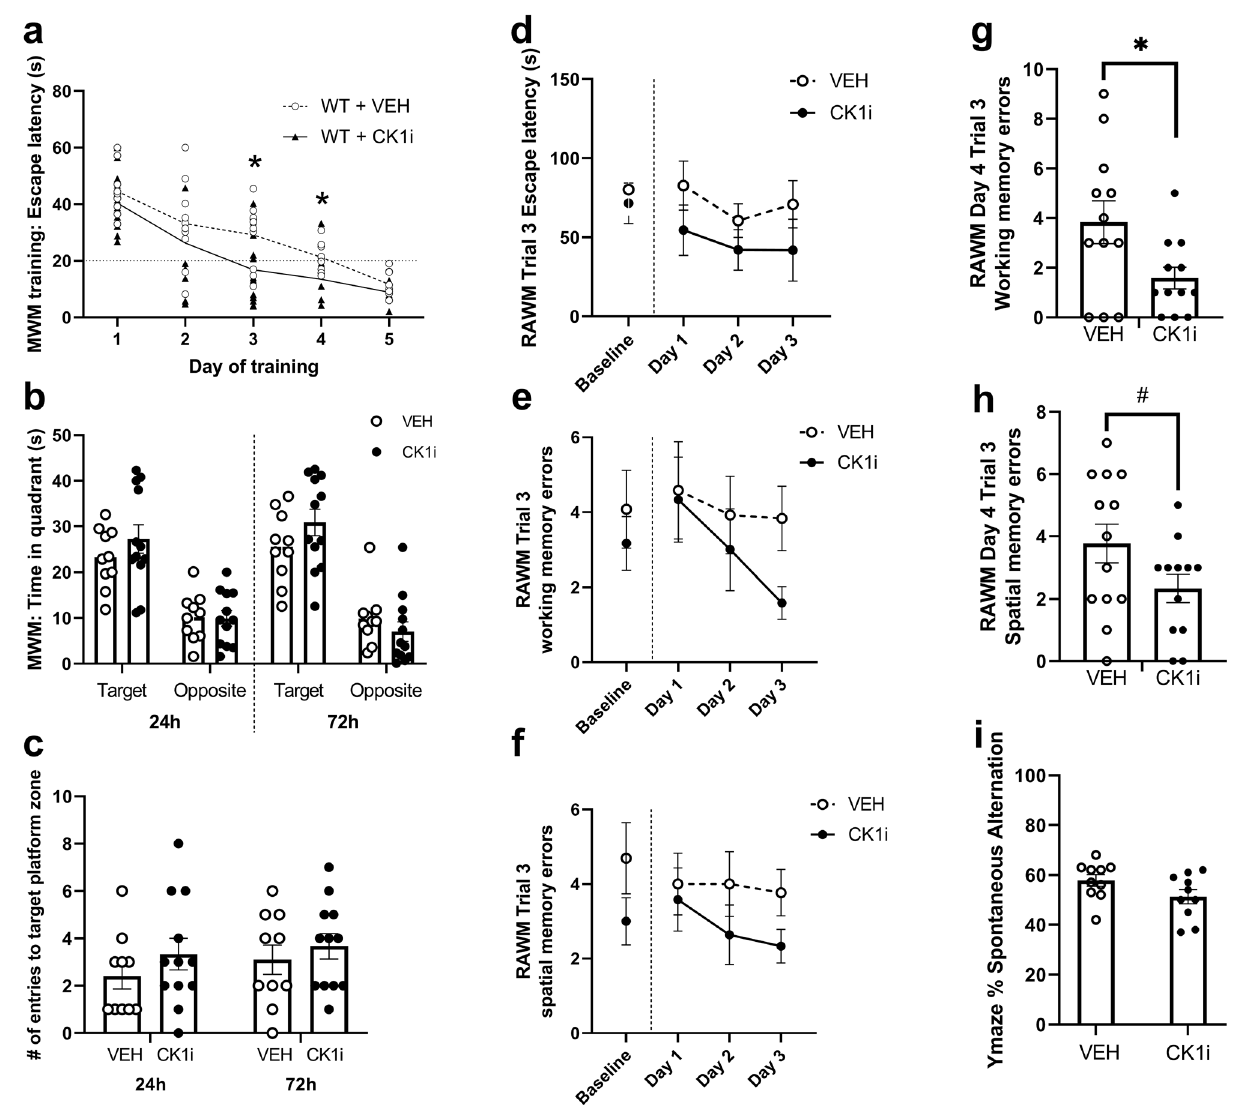
Figure 4. CK1 inhibition with PF-670462 improves spatial learning behavior but not recall in the Morris water maze, and working memory performance in the radial arm water maze but not Y maze. ( a ) Escape latency over 5 days of training in the Morris water maze (MWM). Dotted line indicates goal latency of 20 s. ( b ) Time spent in target and opposite quadrants of the MWM pool during probe trials conducted 24 and 72 h after the completion of training. ( c ) Number of entries during the probe trials to the area of the pool that previously contained the escape platform. ( d ) Escape latency from the 6-arm radial arm water maze (RAWM) over 4 days of testing. ( e ) Working memory type errors over time in the RAWM. ( f ) Spatial memory type errors over time in the RAWM. ( g ) Working memory type errors in RAWM in the final trial on the last day of testing. ( h ) Spatial memory type errors in RAWM in the final trial on the last day of testing. ( i ) Percent spontaneous alternation in the Y-maze. Each dot represents a mouse. Data are represented as mean ± SEM. *p < 0.05, # p = ANOVA was significant for training day (F(2.414, 45.88) = 31.67, p < 0.0001) and treatment (F(1, 20) = 9.365, p = 0.0062), but not the interaction (F(4, 76) = 0.7439, p = 0.5650). CK1i-treated mice found the escape platform more quickly on the third (t(20) = 2.4363, p = 0.0243) and fourth (t(19) = 2.5911, p = 0.0179) days of training. By day 5 of training, untreated mice had similar escape latency to CK1i-treated mice (t(19) = 1.8451, p = 0.0807) (Fig. 4a). We found no difference in the amount of time spent in the target or opposite quadrant, or in the num- ber of entries to the target platform area in either the 24 or 72 h probe tests. (Fig. 4b,c). Although the results from FC and MWM in our first set of behavioral tests both suggested mild improve- ment in cognitive performance, we found a low effect size and wanted to determine whether there were effects on other measures of hippocampus-dependent working memory. We used radial arm water maze (RAWM) to examine both spatial and working memory, and Y-maze to examine working memory in a different context. While group differences over time for the 3 training days were not significant (Fig. 4d–f), we found that CK1i- treated mice made fewer working memory errors in the third trial of the final testing day (t(16.27) = 2.335,